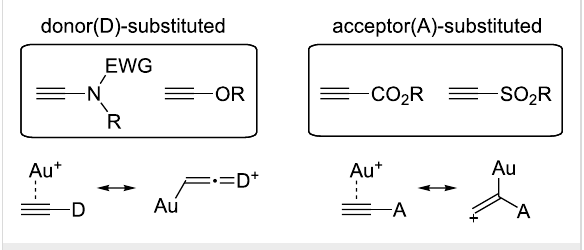
Figure 1: Donor- and acceptor-substituted alkynes for Au-catalyzed intermolecular reactions.